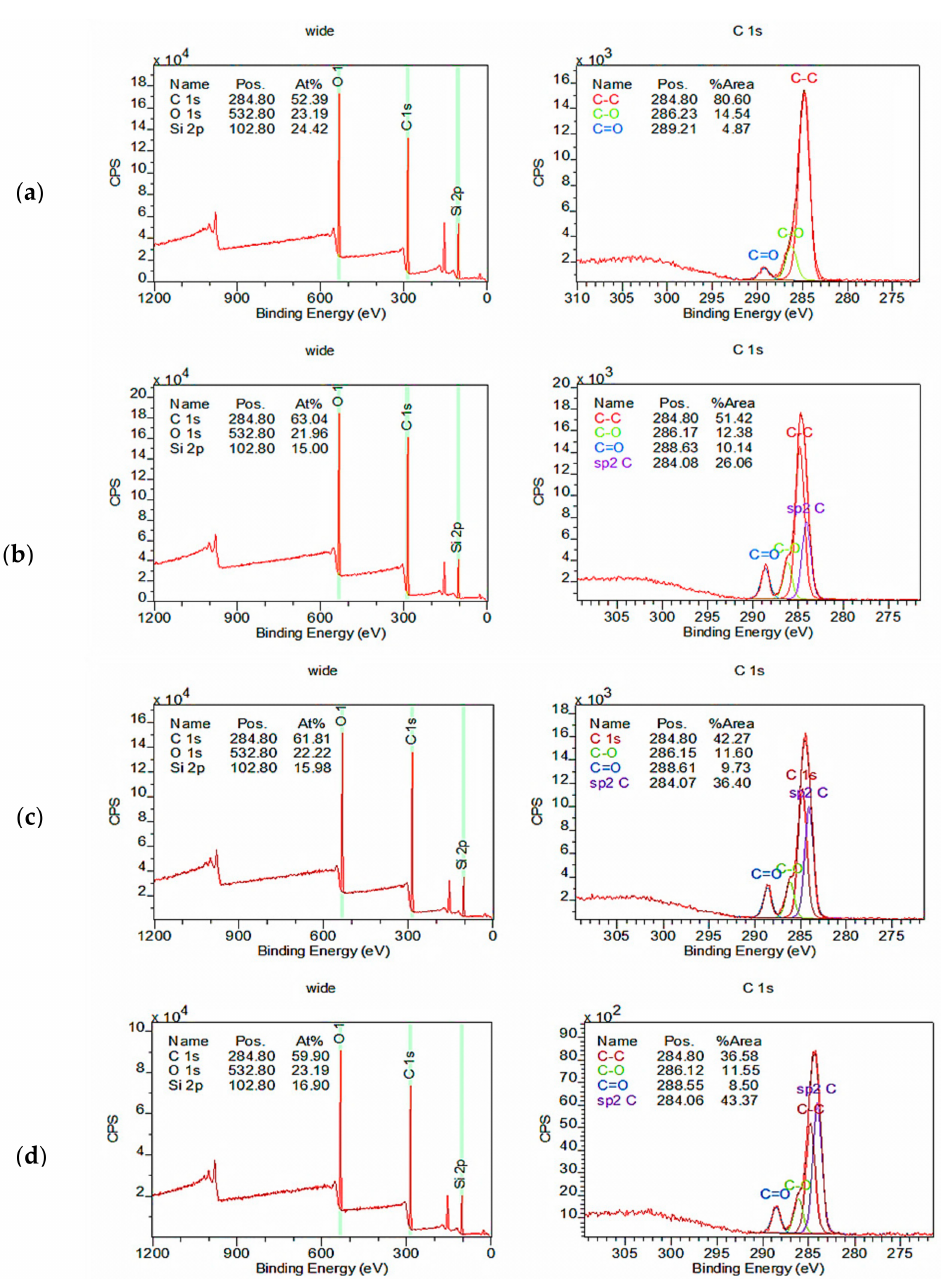
Figure 4. XPS spectra of a complete survey spectrum (left) and C1s spectrum (right) of membrane with di ff erent nanomaterial loadings: ( a ) 0.0 wt%, ( b ) 0.4 wt%, ( c ) 0.8 wt%, and ( d ) 1.0 wt%